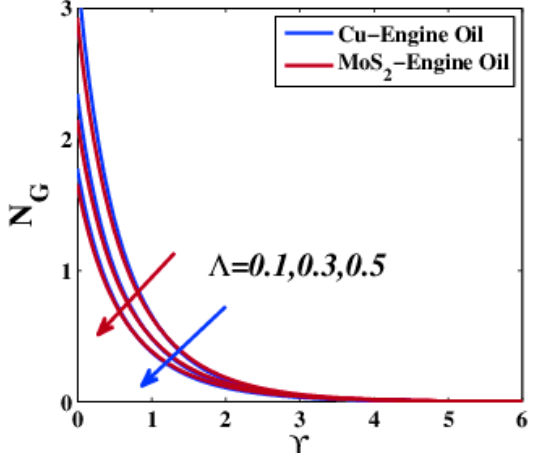
Figure 18. Entropy generation variation N G under the influence of Λ .